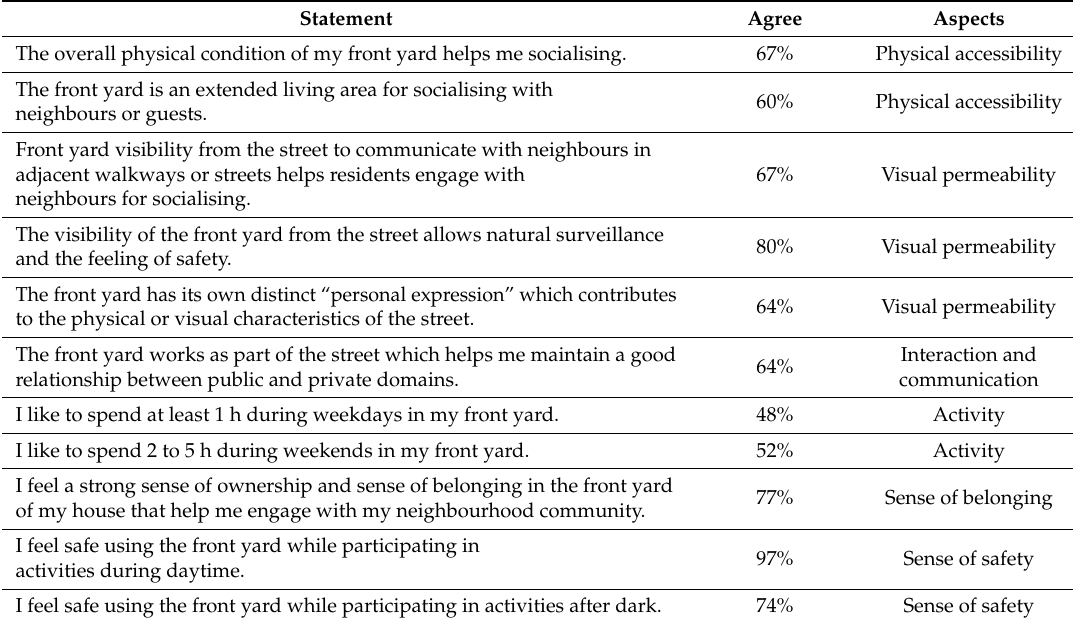
Table 5. Perception survey of Subiaco